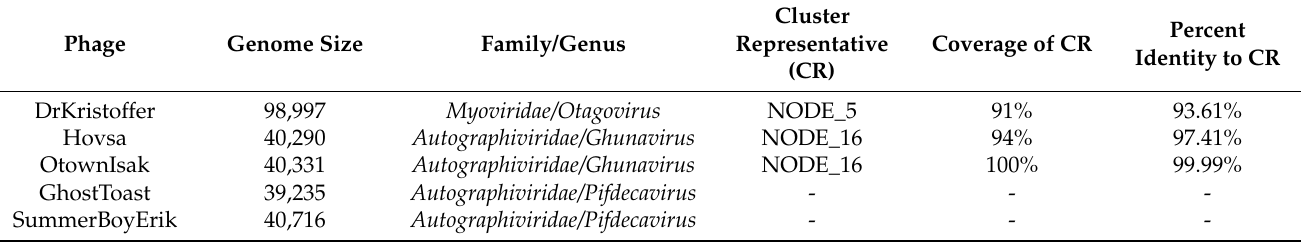
Table 2. Overview of the five plaque-forming phages isolated against DC3000 from the same OW sample used for DC3000 + and DC3000 − viromes. All blast hits had an e-value of ~0. GhostToast and SummerBoyErik did not have any cluster